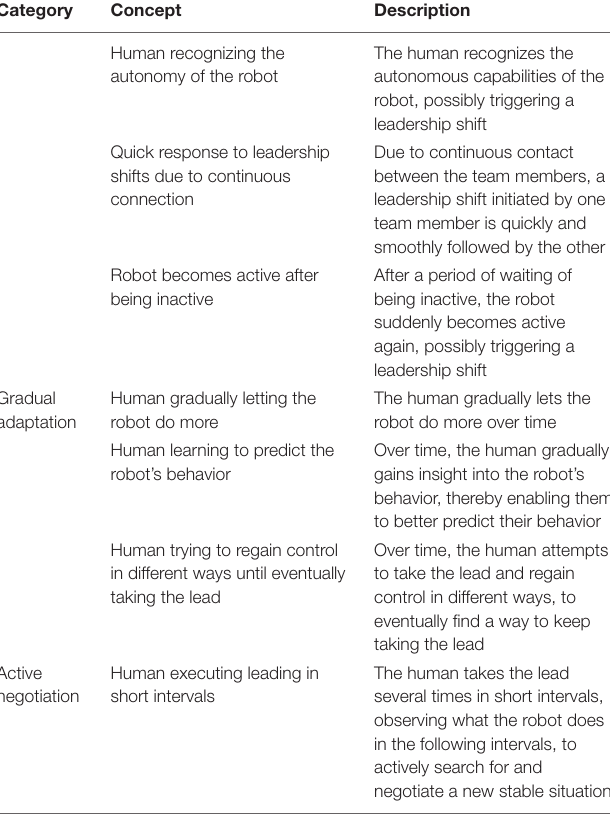
TABLE 7 | The interaction patterns that fall in the category of sudden adaptations described in more